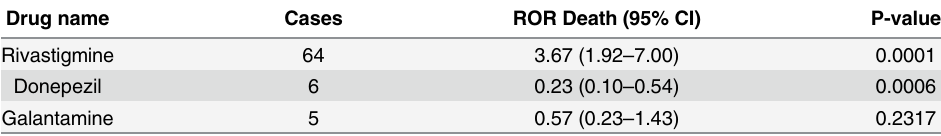
Table 3. Analysis of death reports in the Canada Vigilance Adverse Reaction database.